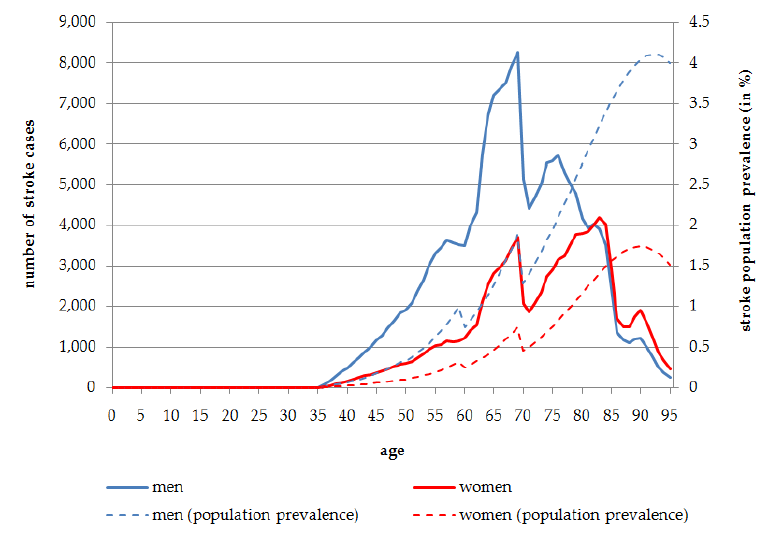
Figure 3. Number of persons affected by stroke attributable to SHS exposure, stratified by age and sex, Germany,